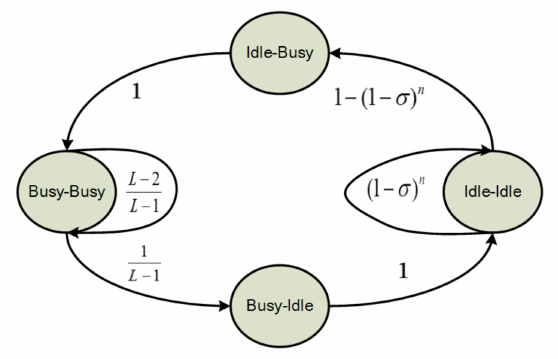
Figure 3. Adjacent-slot-pair-wise channel state model from [19].